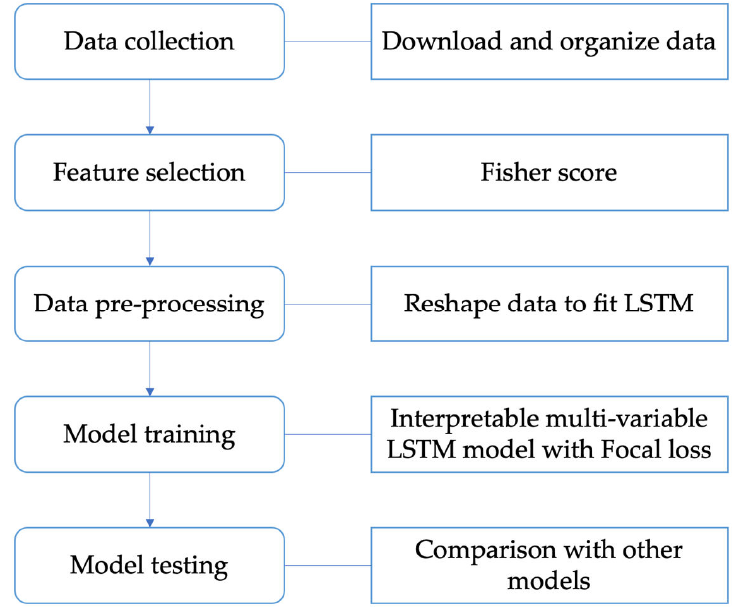
Figure 1. This research architecture.